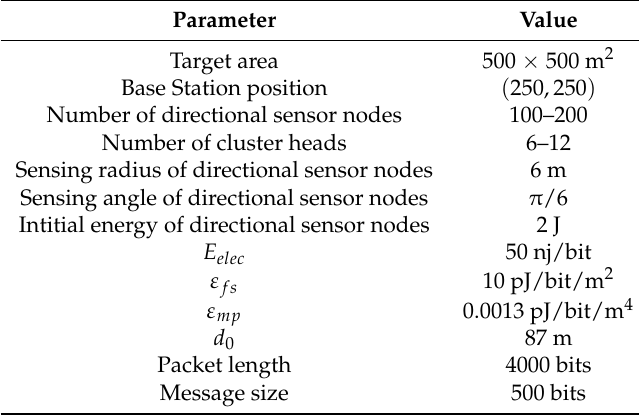
Table 1. Network parameters.